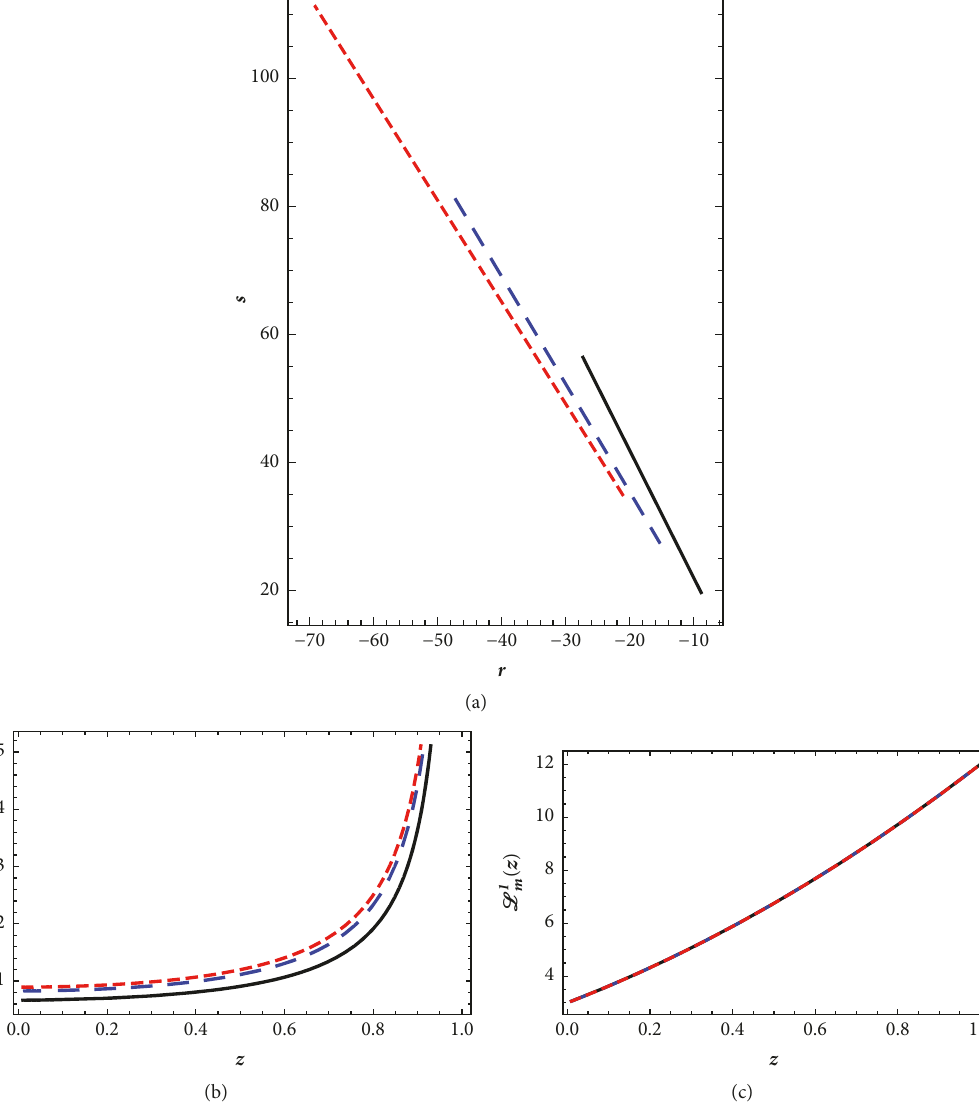
Figure 2: (a) The 𝑟 s trajectories, (b) 𝑂𝑚 , (c) L 1 𝑚 as function of red-shift 𝑧 for 𝛼 = 0.8502 and 𝛽 = 0.4817